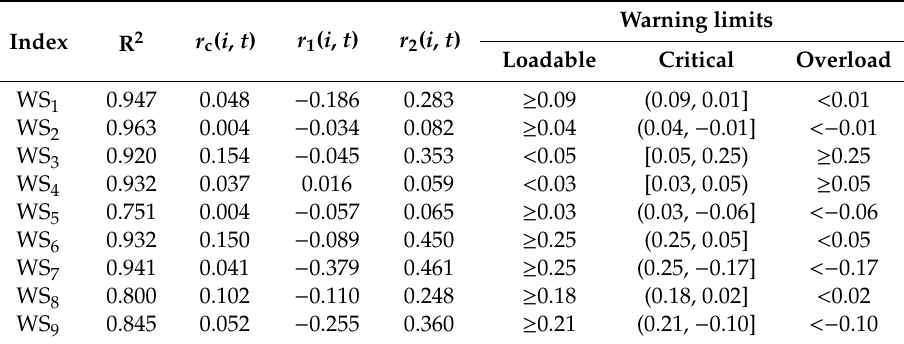
Table 5. EWSI warning limits for EWS-RWRCC in Anhui